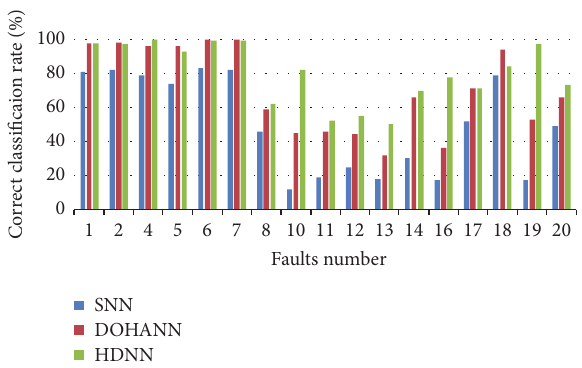
Figure 14: Correct classification rate of SNN, DOHANN [76], and HDNN